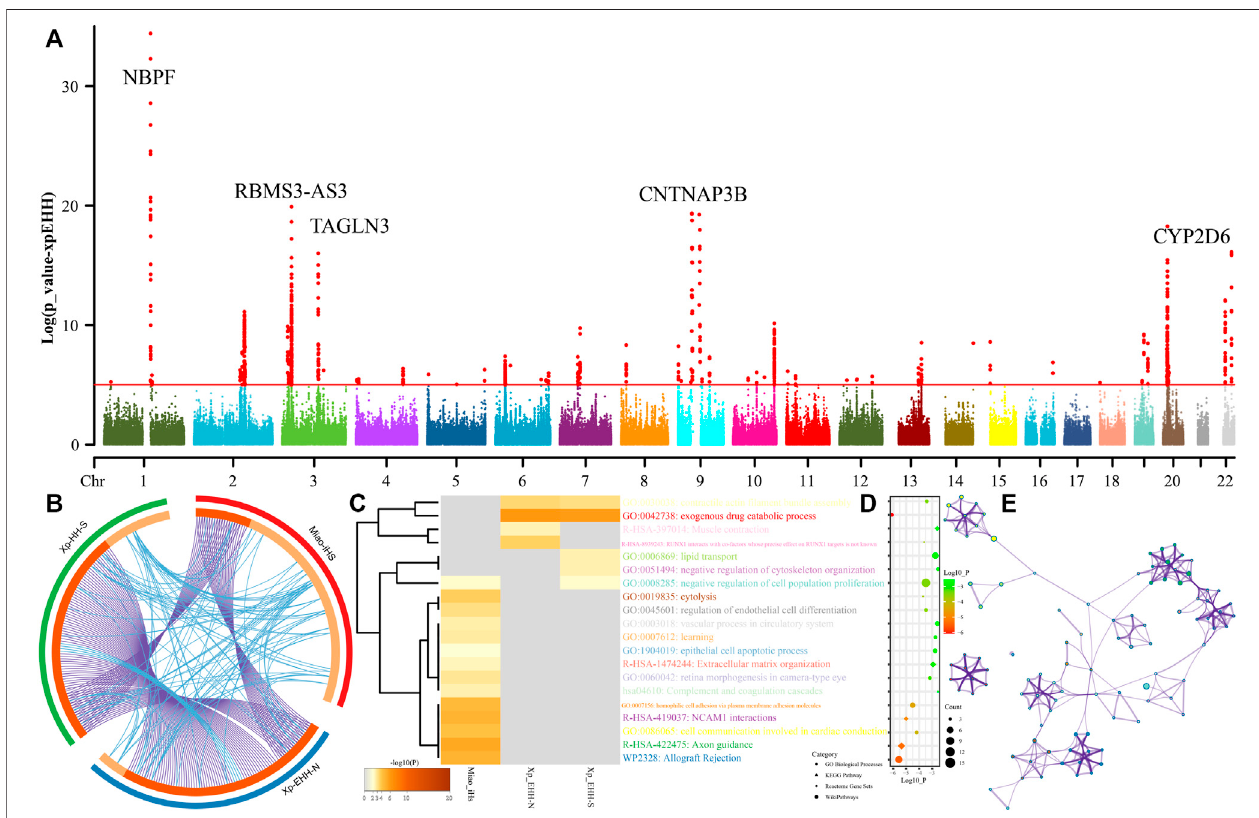
FIGURE 8 | Manhattan showed the natural selection signatures and enrichment analysis. (A) p -values of XPEHH in the Miao population using northern Han as the reference population. (B) Overlap among three gene lists based on gene-level and shared-term level, where blue curves link genes that belong to the same enriched ontologyterm.Theinner-circlerepresentsgenelists,wherehitsarearrangedalongthearc.Genesthathitmultiplelistsarecoloredindarkorange,andgenesuniquetoa list are shown in light orange. (C) Heatmap of top twenty enriched terms across three input gene lists, colored by p -values. (D) Top 20 clusters with their representative enriched terms. (E) Network of enriched terms colored by cluster-ID.